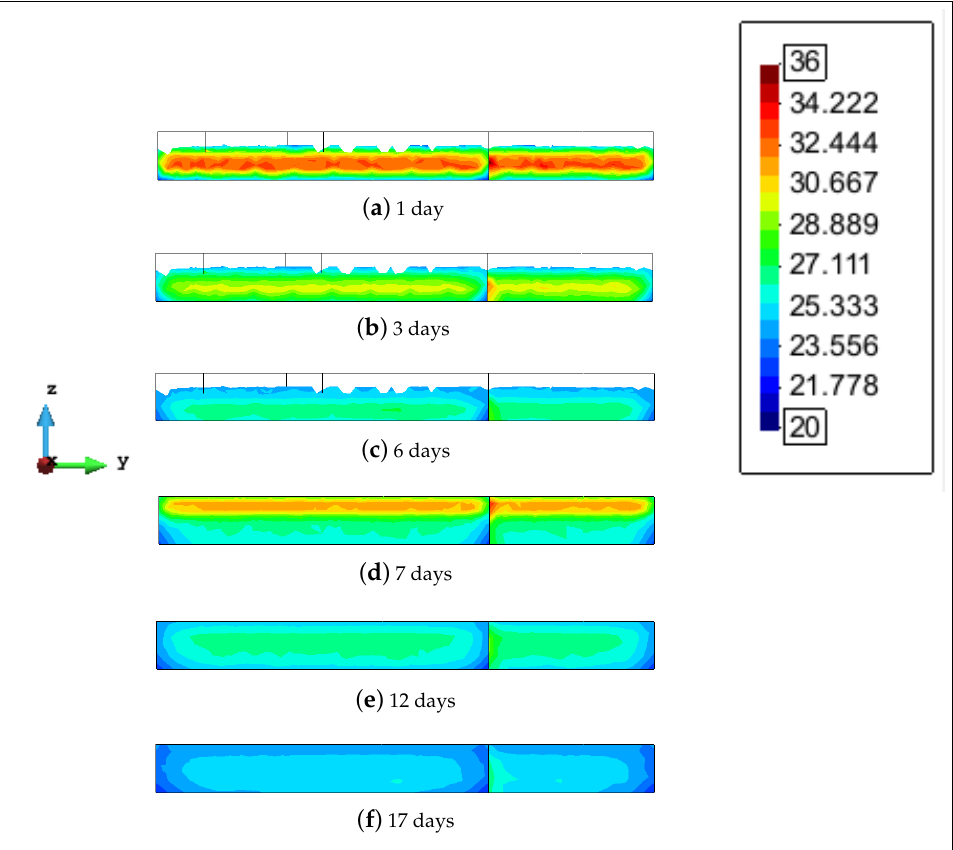
Figure 8. Temperature fields related to ages of 1, 3, 6, 7, 12 and 17 days for the optimal solution.